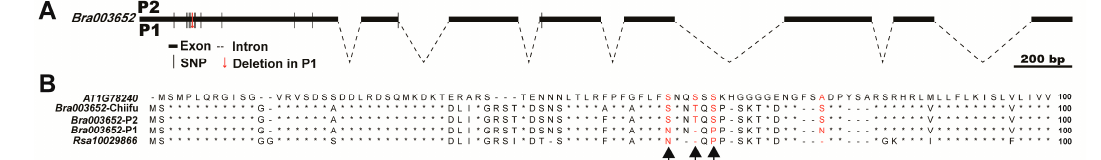
Figure 7. Analysis of genes structure and alignment of protein sequences. ( A ) The Bra003652 gene structure and natural variations between the alleles from P2 and P1; ( B ) Alignment of protein sequences among homologous genes from Arabidopsis , Chiifu (Chinese cabbage), P2 (Chinese cabbage), P1 (turnip), and radish. Red numbers indicate the positions of the amino acid variations between P2 and P1. Black arrows indicate the variations that were the same between Bra003652 -P1 and Rsa10029866 .